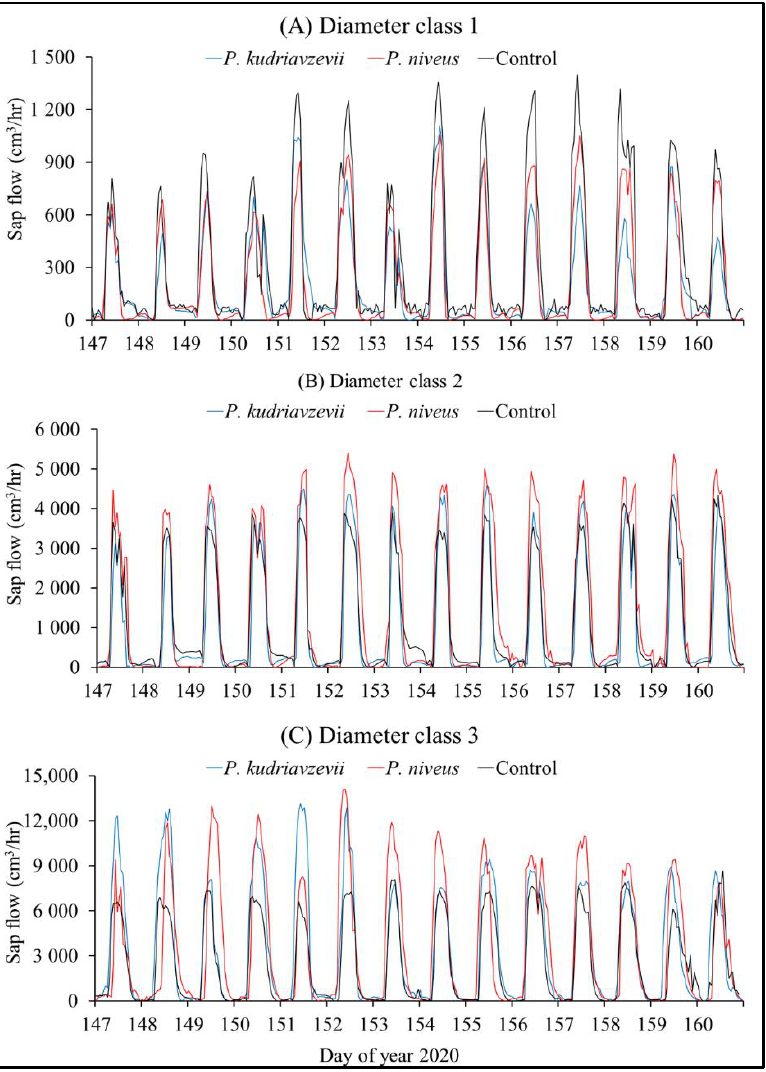
Figure 10. Daily SF Rate of inoculated trees with fungi P. kudriavzevii , P. niveus and uninoculated (control) trees of A. malaccensis at ( A ) small-diameter classes (DC1), ( B ) medium-diameter classes (DC2), and ( C ) large-diameter classes (DC3) .